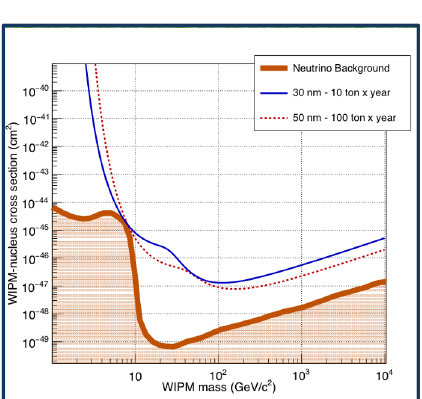
Figure 4. Discovery potential of an emulsion detector with di ff erent track length thresholds and